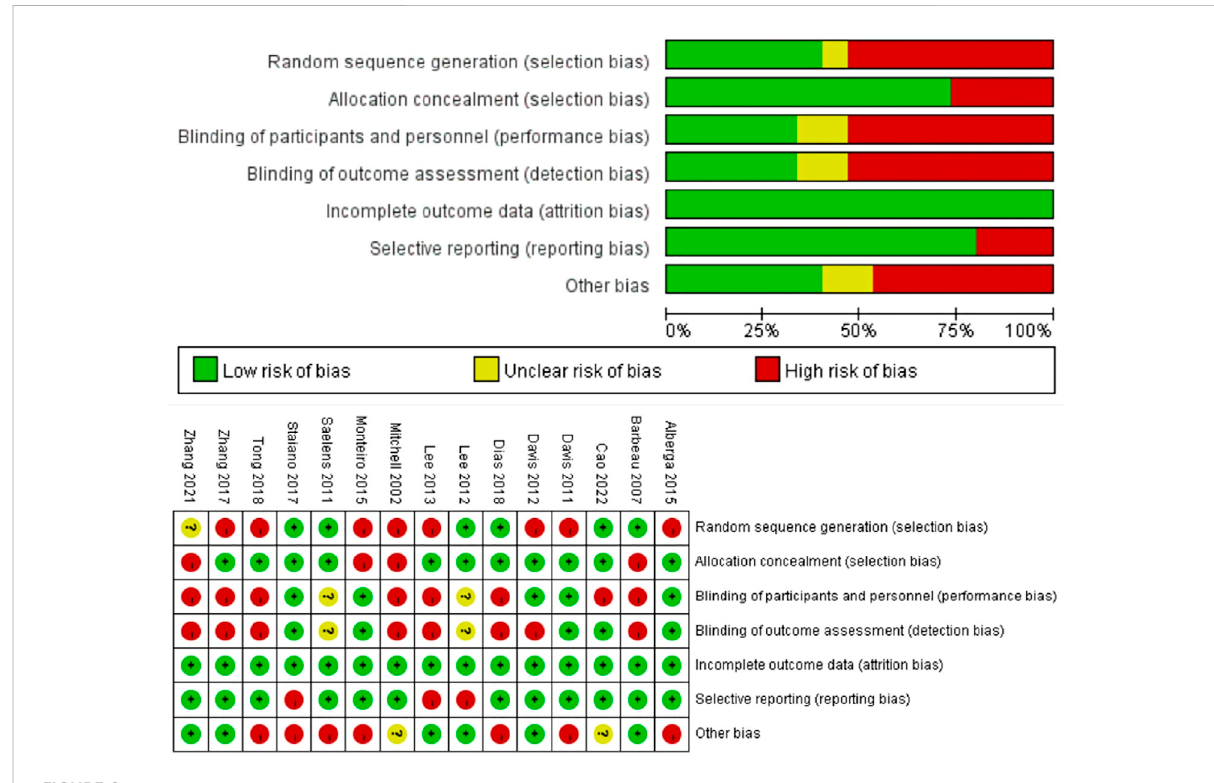
FIGURE 2 The bias of the included